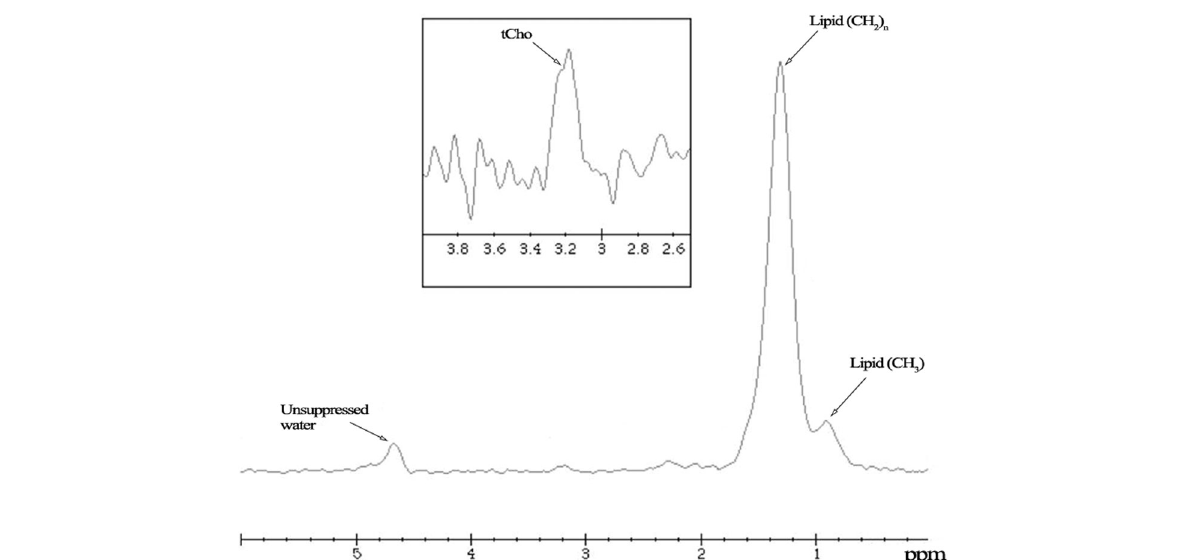
Fig. 3 1 H-MRS of the breast gland in a healthy fertile 24-year-old woman not using oral contraceptives. A clear peak of choline-containing compounds (tCho) is visible at about 3.2 ppm, giving an absolute concentration of 0.6 mM. Three main resonances are visible at about 0.9 ppm and 1.2 ppm due to lipids as well as at about 4.7 ppm due to unsuppressed